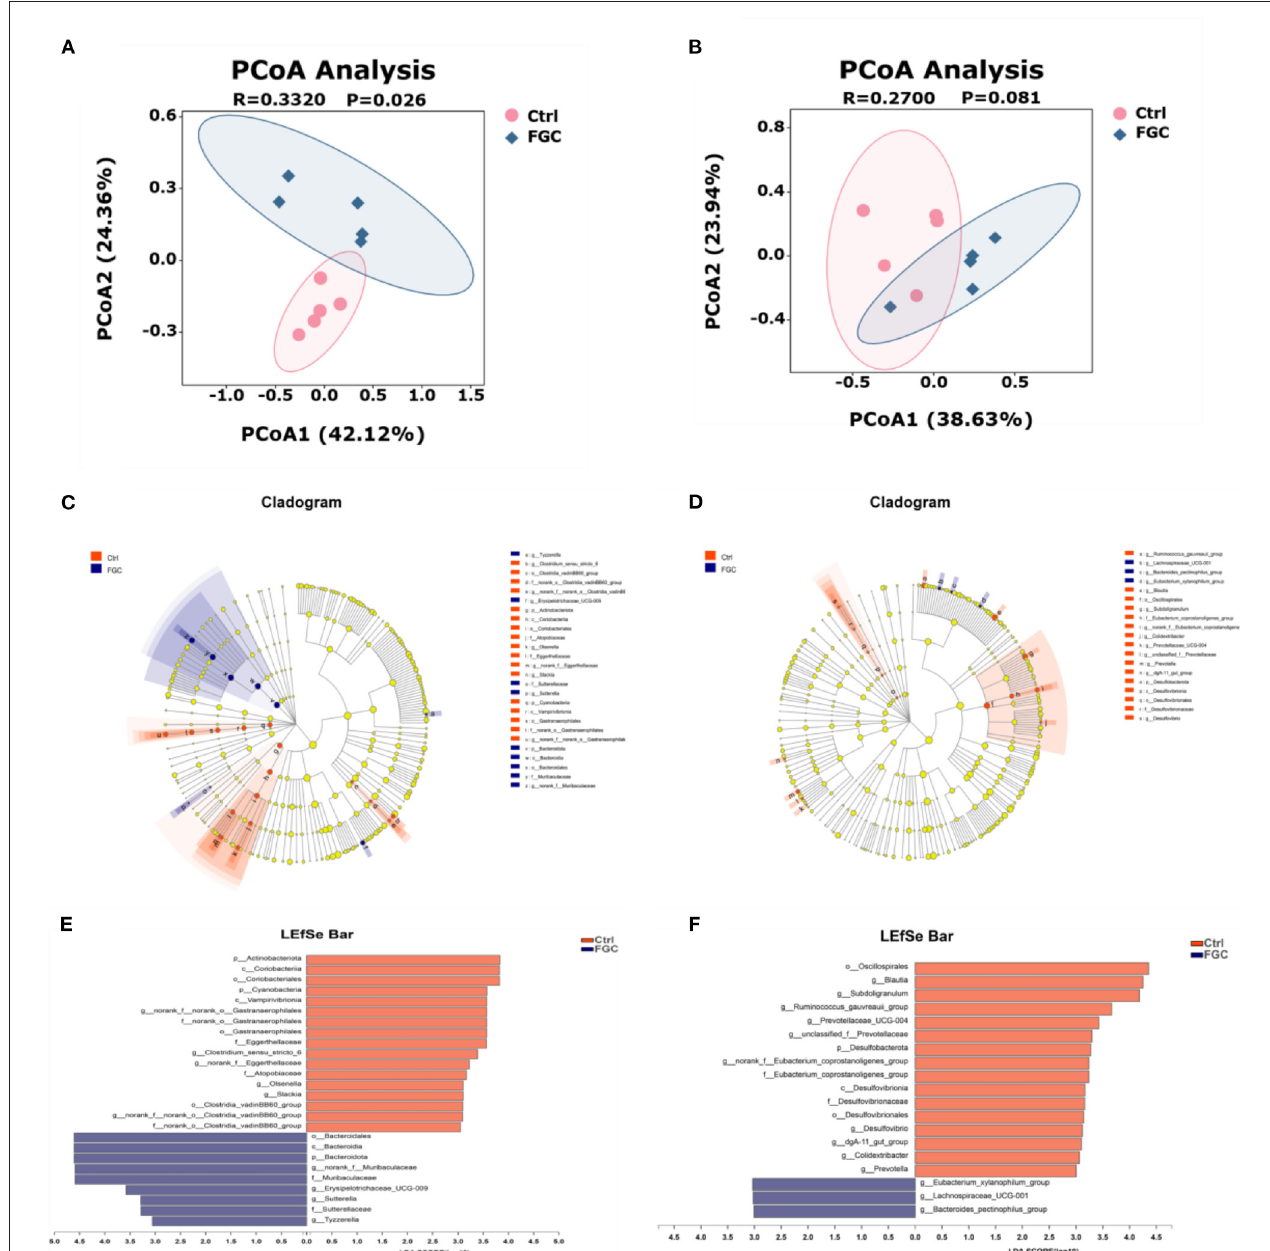
FIGURE 7 | Fecal microbial β -diversity at OTU levels and LEfSe analysis from phylum to genus level of 14d and 28d-piglets. (A) PCoA of 14d-piglets 14. (B) PCoA of 28d-piglets. (C) Cladogram of 14d-piglets. (D) Cladogram of 28d-piglets. (E) LDA of 14d-piglets. (F) LDA of 28d-piglets. p < 0.05 and LDA score > 3 were presented. LEfSe, linear discriminant analysis effect size; PCoA, principal co-ordinate analysis; LDA, linear discriminant analysis. Ctrl, corn-soybean basal diet; FGC, corn-soybean basal diet with 2,000 mg/kg ferrous glycine chelate. N =